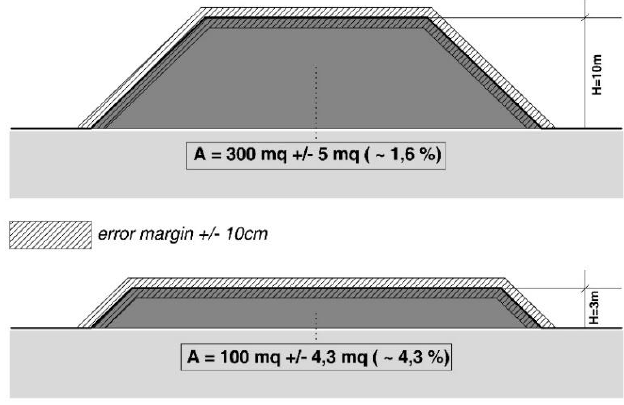
Figure 9. Influence of the shapes on volume computation errors.